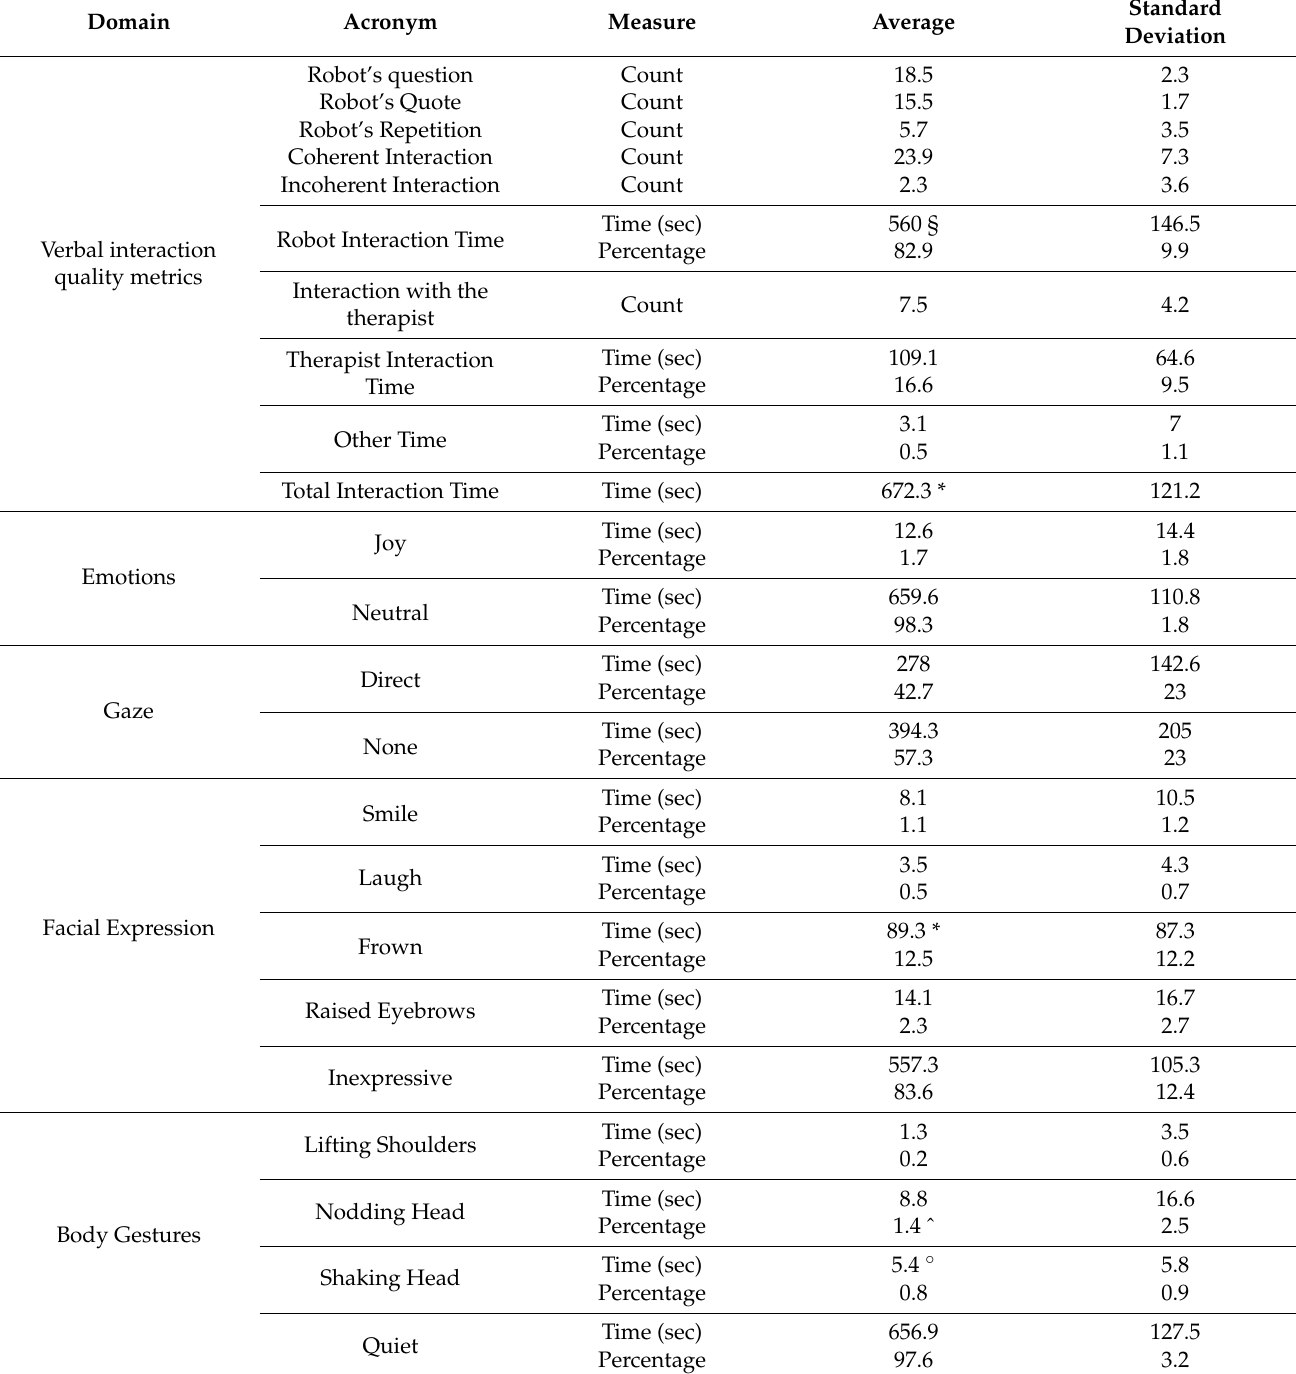
Table 3. Descriptive statistics of the verbal and no-verbal parameters extracted from the video analysis.